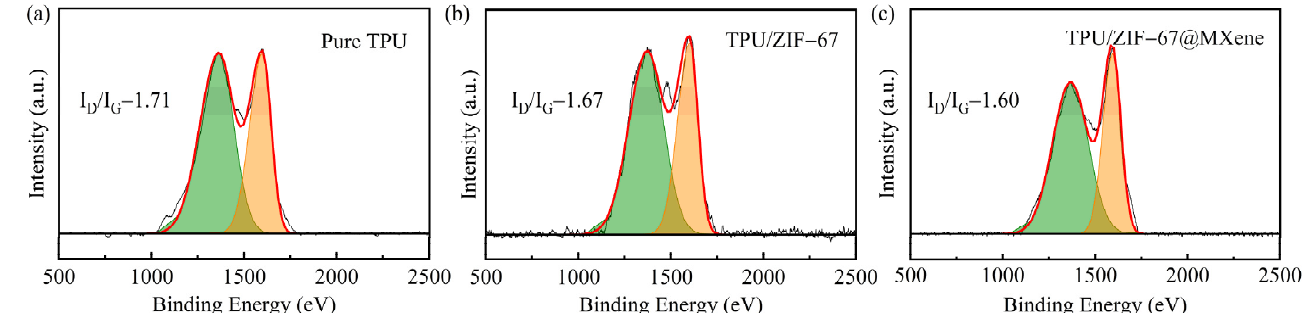
Figure 9. Rama spectra of residual char of pure TPU ( a ), TPU/ZIF-67 ( b ), and TPU/ZIF-67@MXene ( c ) composites.